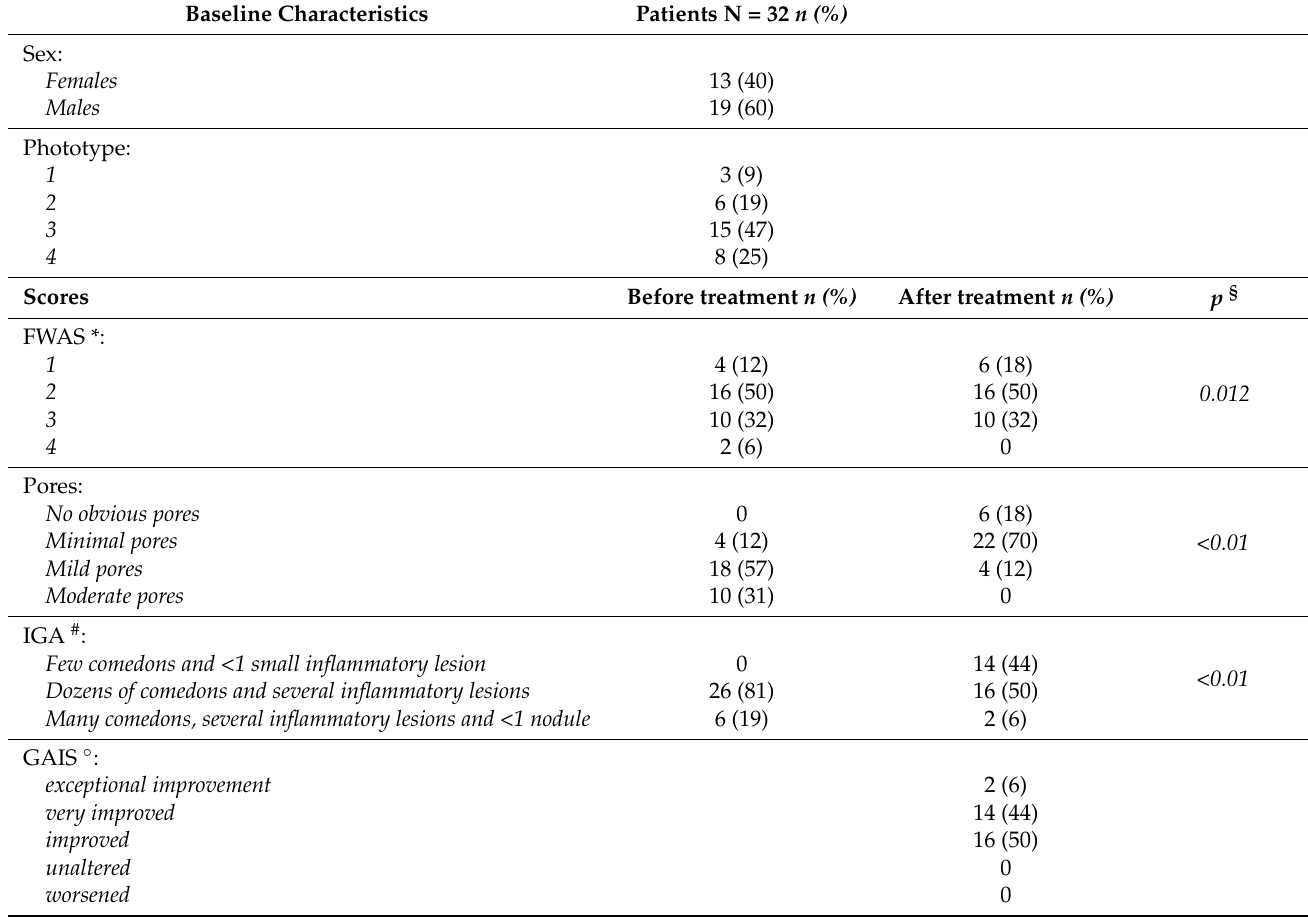
Table 1. Characteristics of patients treated with carbon peeling laser